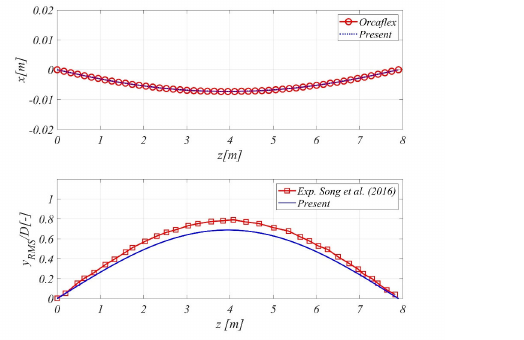
Figure 16. Static configuration and cross flow displacement with uniform current.